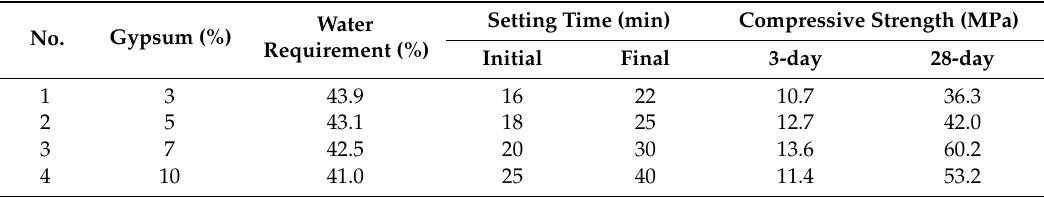
Table 2. Performance of fly ash belite cement (FABC) with di ff erent gypsum contents.